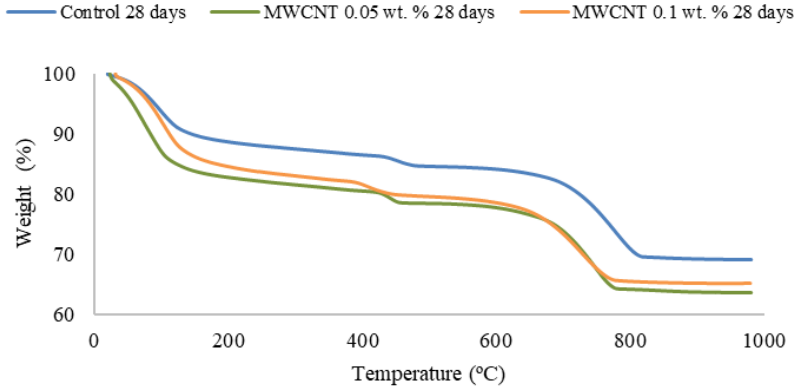
Table 3. Density results of control sample and CNTs reinforced cement samples.